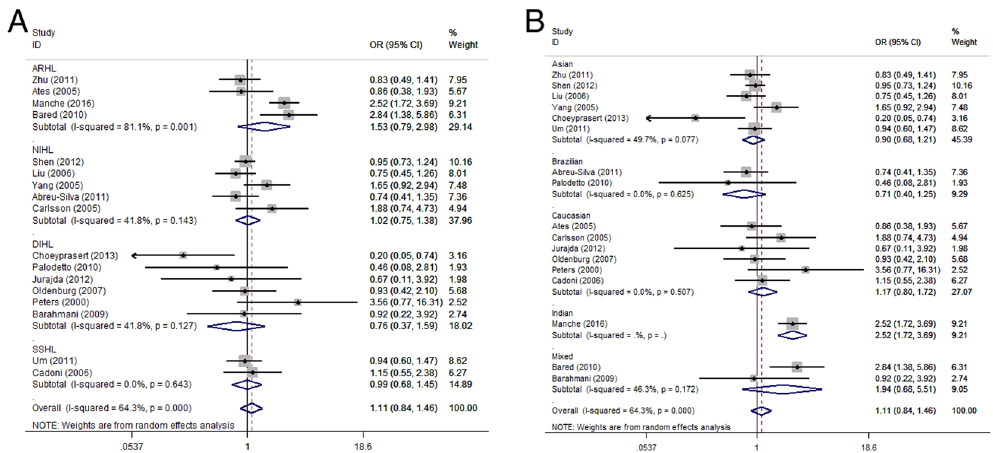
Figure 4. Subgroup analysis of the association between GST T1 and the susceptibility to acquired SNHL according to the acquired SNHL types ( A ) and ethnicity ( B ).